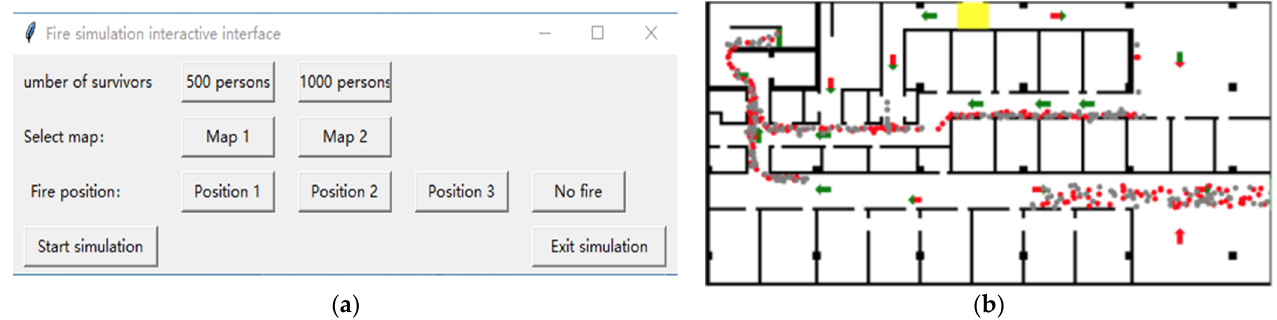
Figure 13. The software interface and evacuation system of the evacuation system in the west building of the Capital Airport Emergency Center: ( a ) Evacuation parameter control interface.; and ( b ) evacuation 2D dynamic display interface. Table 2. Comparison of the simulation